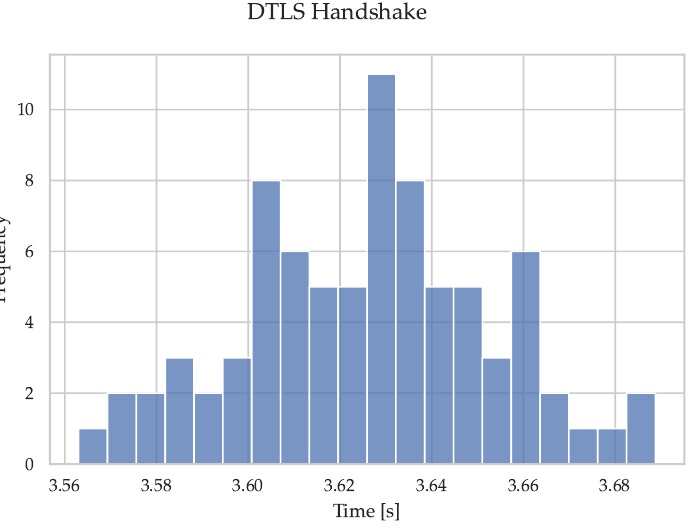
Figure 12. Execution time of the DTLS handshake using MbedTLS including outliers.